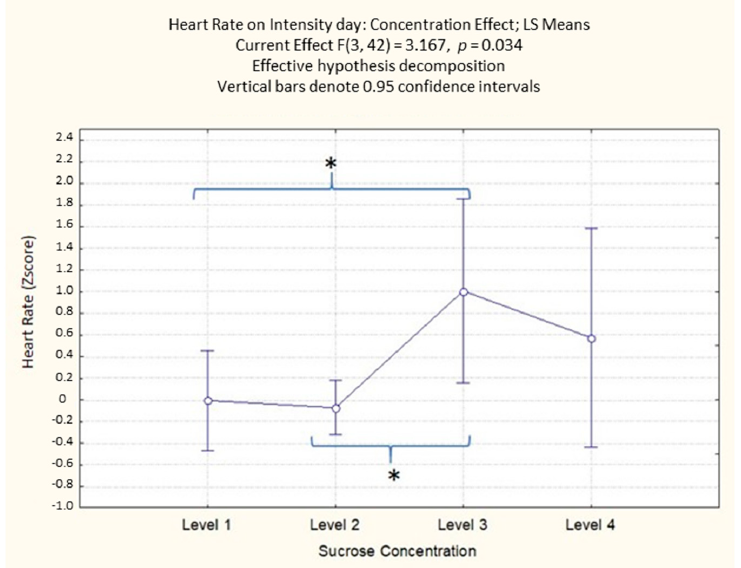
Figure 7. Concentration effect on HR with different sucrose concentration levels in the intensity evaluation day. The order of the levels corresponds with the different sucrose amounts (38; 83; 119; 233 g/kg). * Denotes a significance level <0.05.